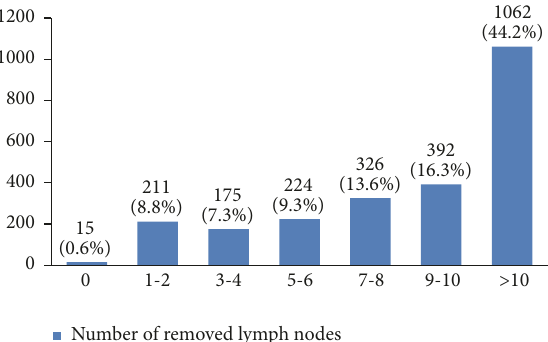
Figure 14: The diabetes status of the studied breast cancer cases.